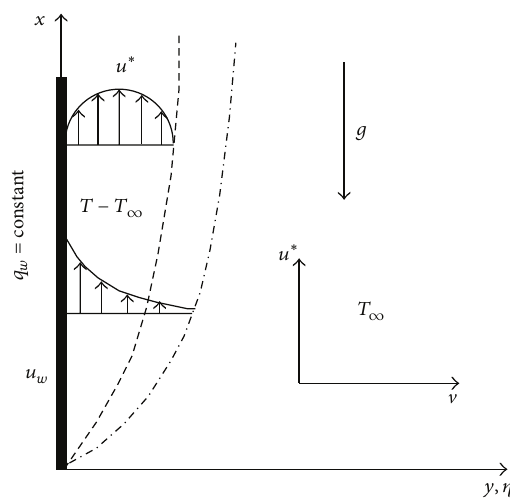
Figure 1: Physical model for laminar flow over stretching